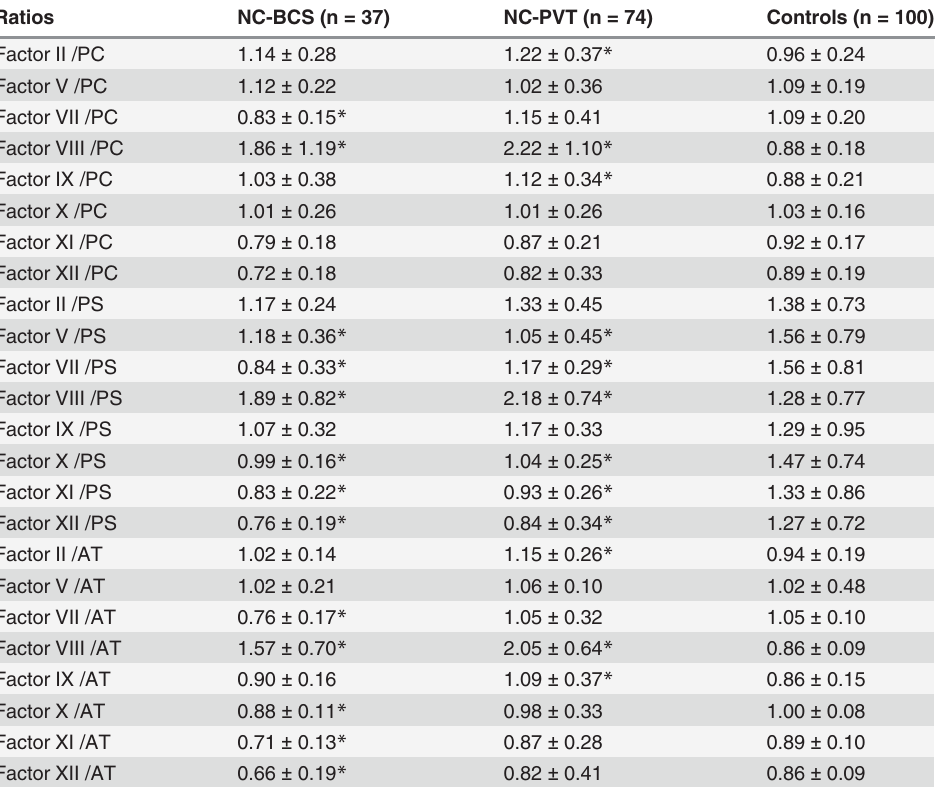
Table 3. Ratios between pro- and anti-coagulant factors for patients with NC-BCS, NC-PVT and healthy controls. Ratios